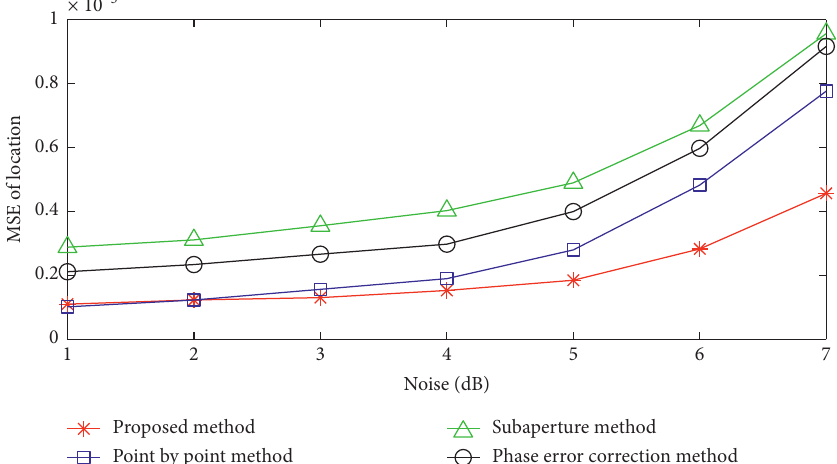
Figure 9: Relationship between estimated accuracy of four methods and noise